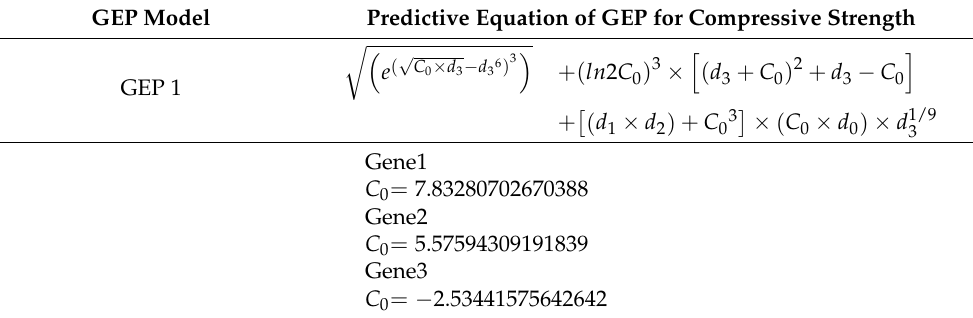
Table 8. The mathematical formulation of compressive strength of concrete samples containing nano-MgO proposed by the GEP